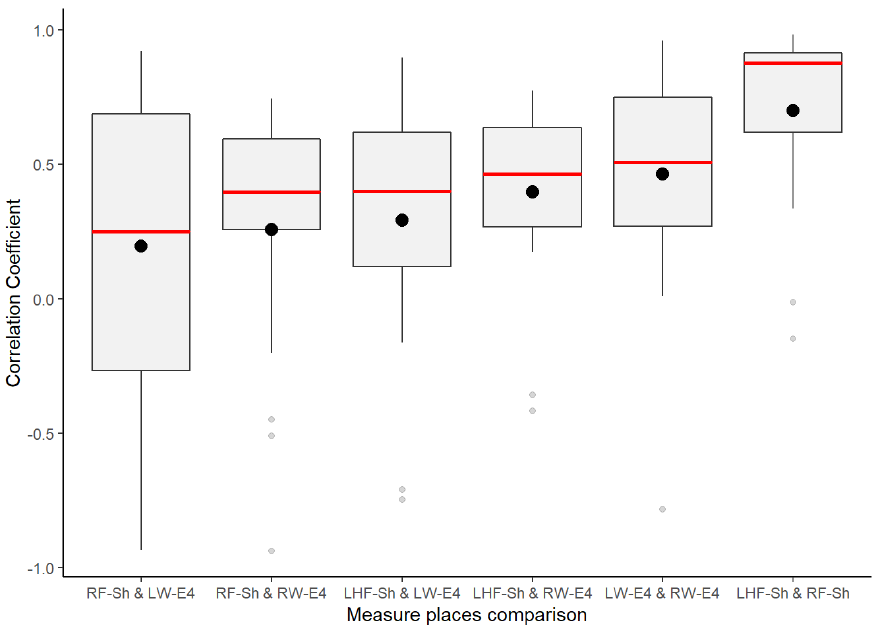
Figure 14. Box plot distributions of the coefficient correlations from the correlations between sig- nals.